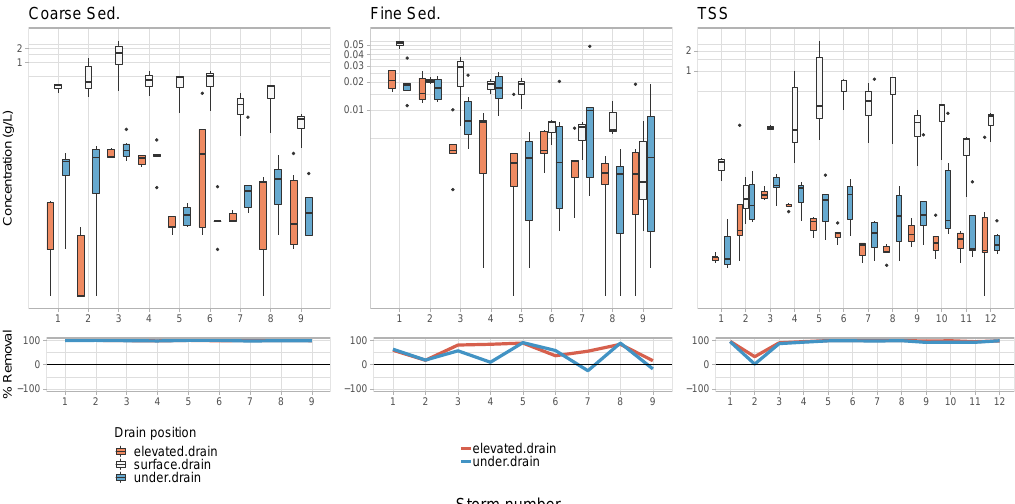
Figure 3. Effluent concentrations for coarse, fine, and total suspended solids grouped by storm and drain position [upper row]. The lower panel shows pollutant removal efficiencies across all measured storms. Removal efficiencies plotting below the 0% removal efficiency line illustrate sediment-exporting storm events (e.g., fine sediment: Storms 7 and 9 at the under